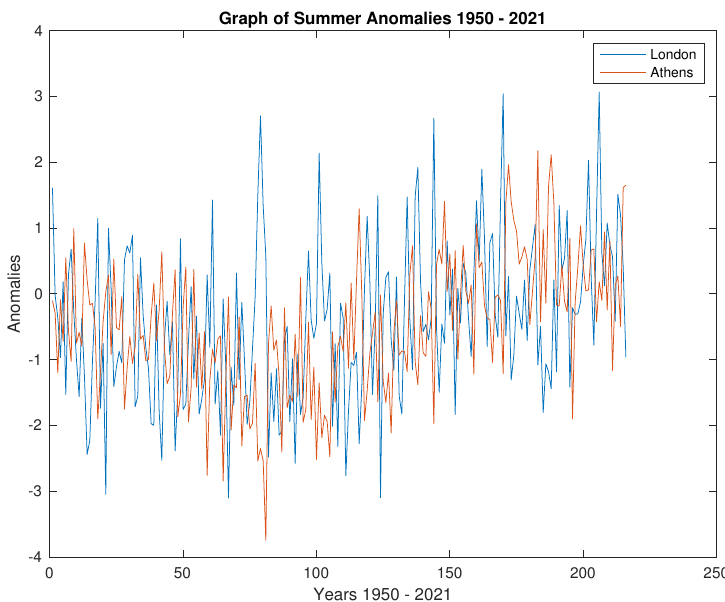
Figure 20. Graph of Summer Anomalies